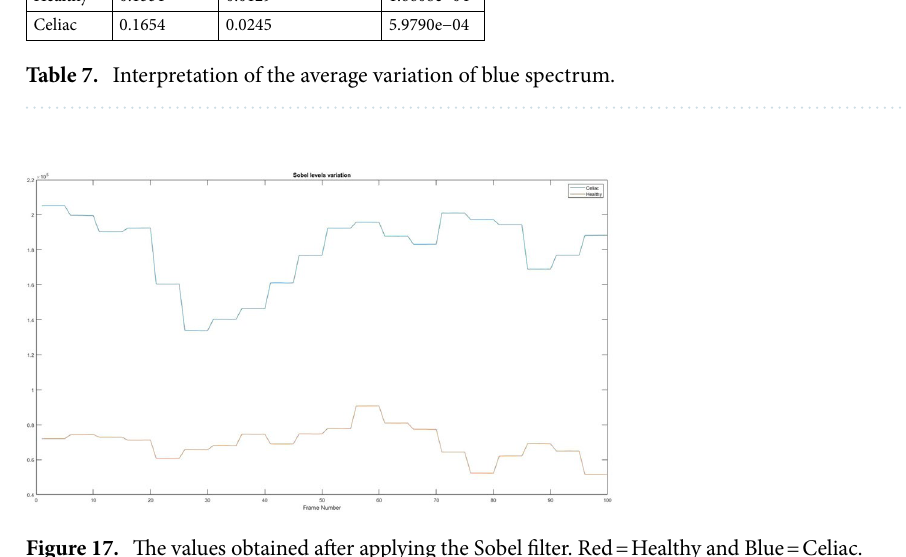
Figure 17. The values obtained after applying the Sobel filter. Red = Healthy and Blue = Celiac.